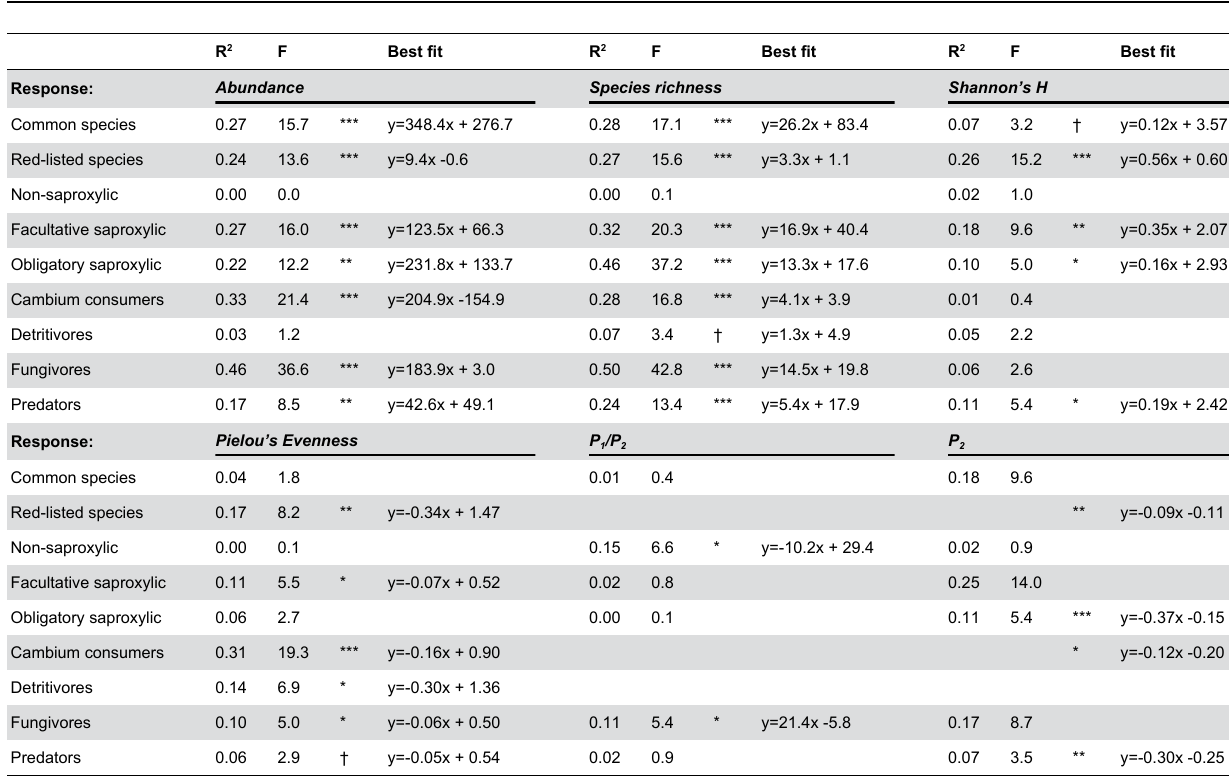
Table 4. R 2 and F values, best fit lines and significance of relationship between response variables and log(age) in regression